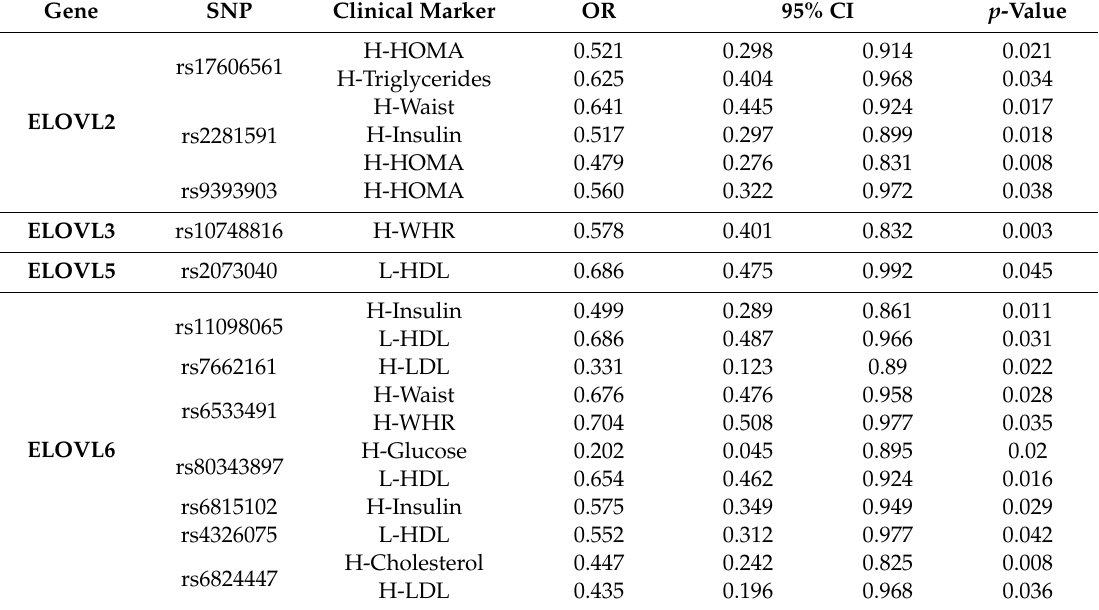
Table 5. Association between SNP of ELOVL and clinical markers of chronic non-communicable diseases (protective